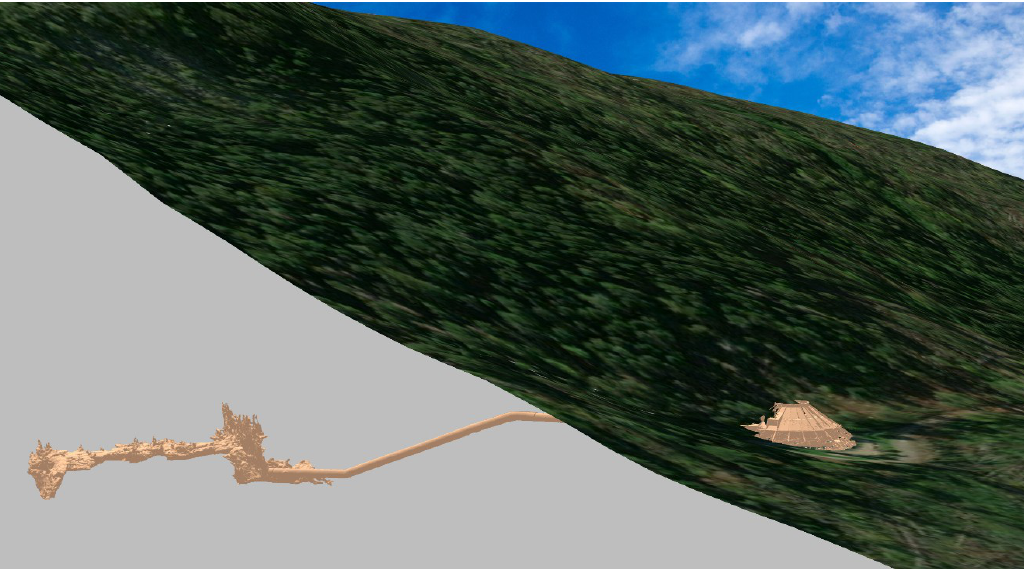
Figure 9. Position of the 3D model of the cave with respect to the surrounding digital terrain model.